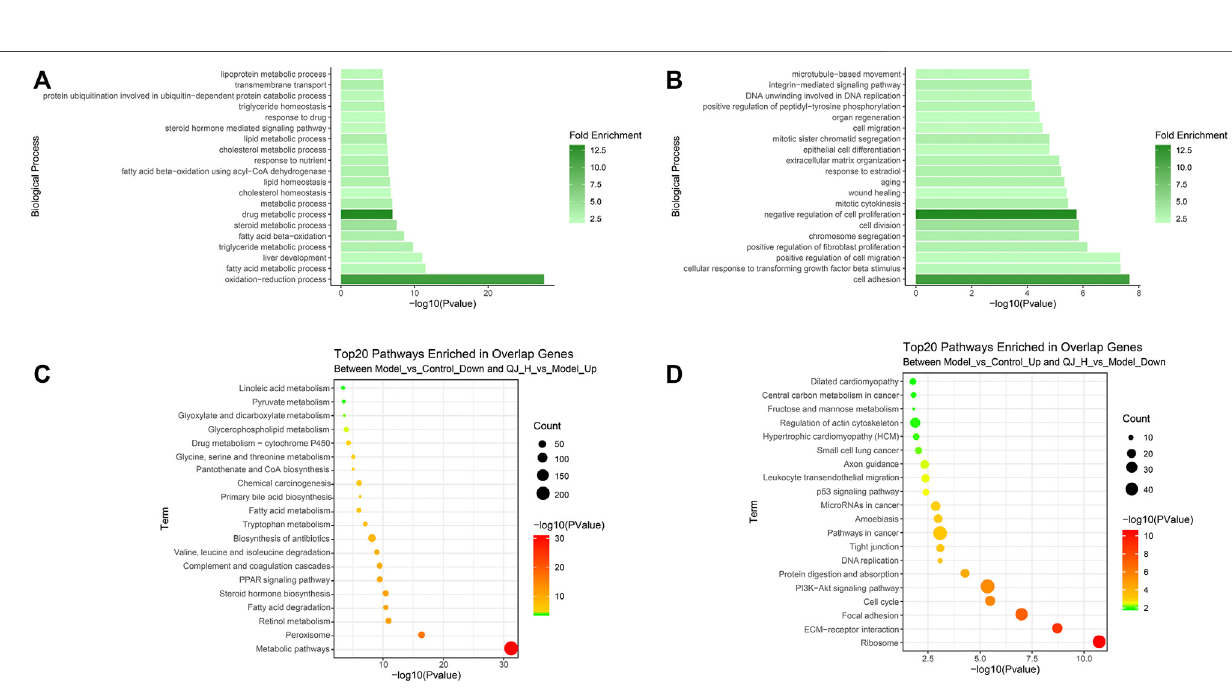
Frontiers in Pharmacology |